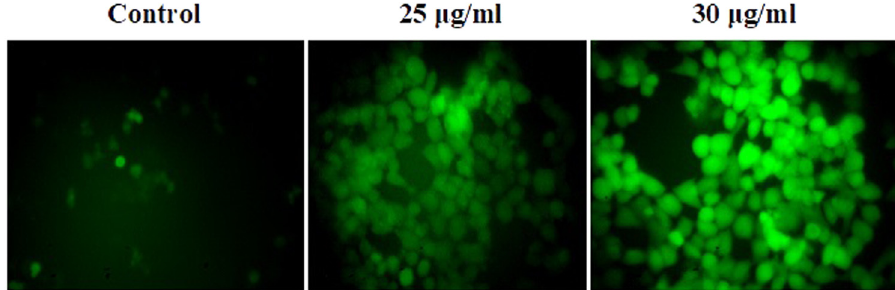
Figure 9: E ff ect of CuO NPs on the intracellular ROS generation in HCT - 116 cells.